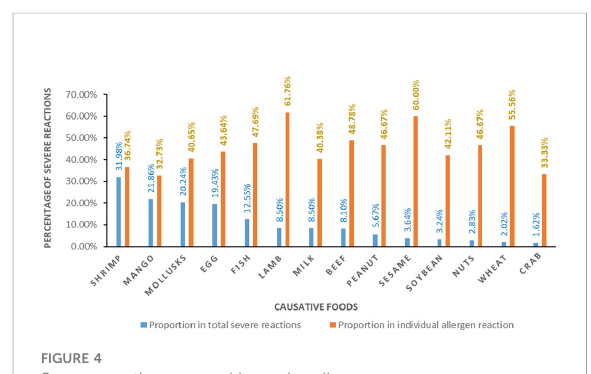
FIGURE 4 Severe reactions caused by major allergens.